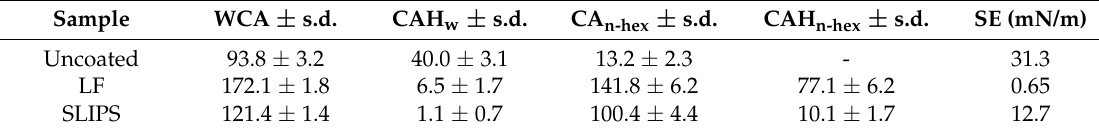
Table 1. Static contact angle against water (WCA) and n-hexadecane (CA n-hex ), contact angle hysteresis against water (CAH w ) and n-hexadecane (CAH n-hex ), surface energy (SE) of uncoated and coated aluminum samples. Standard deviation (s.d.) is reported as